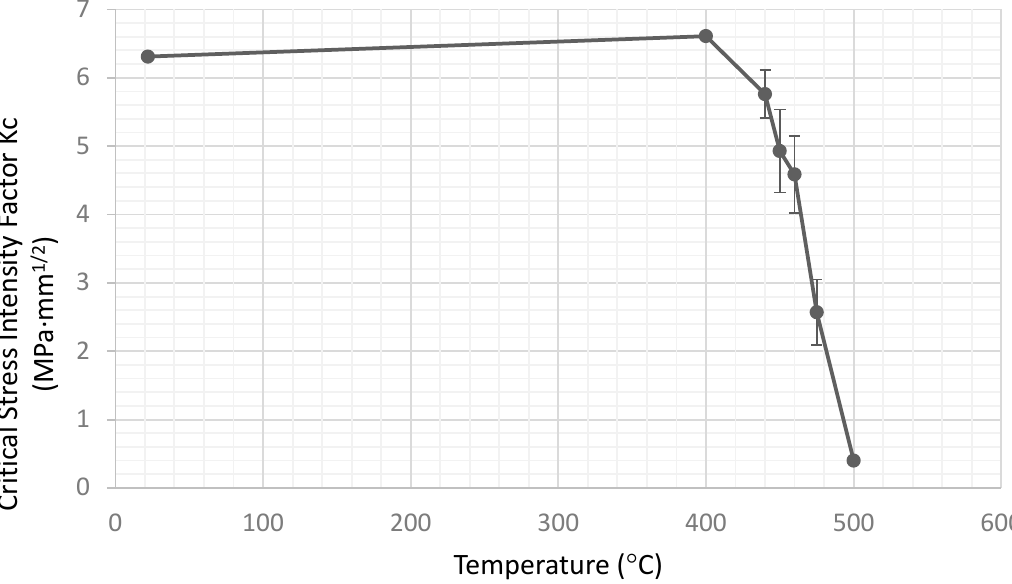
Figure 11. Critical stress intensity factor versus testing temperature.